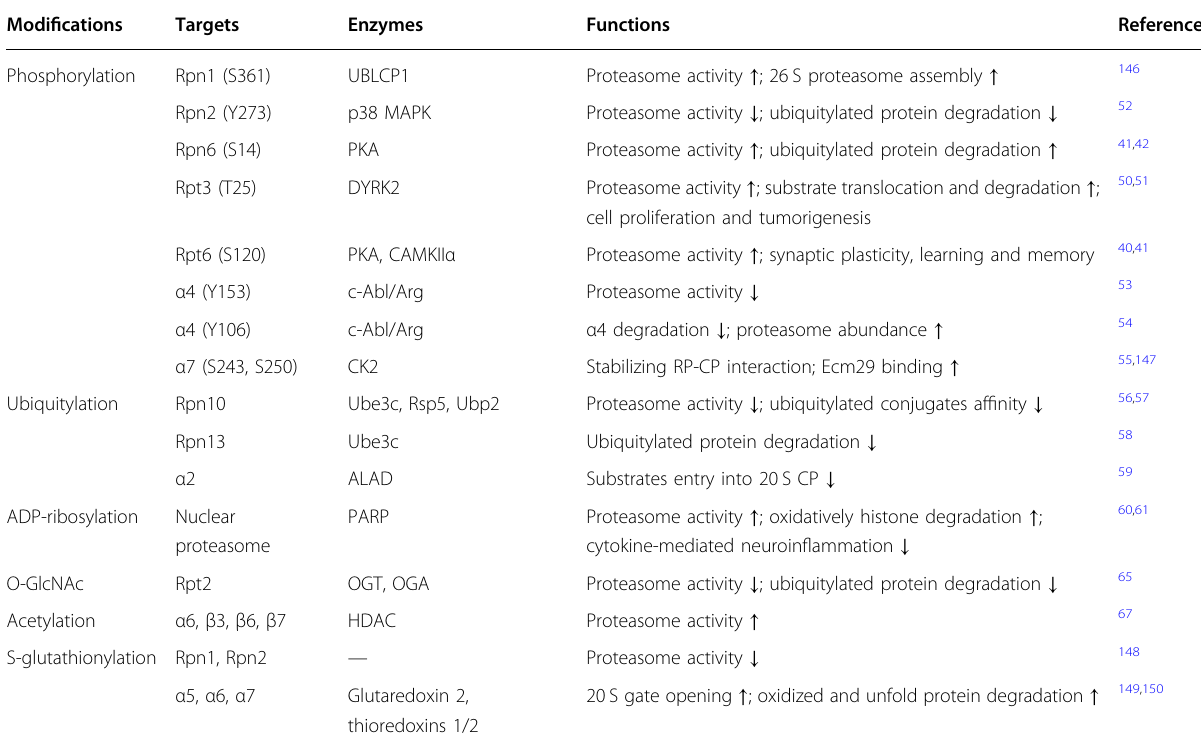
Table 2 An overview of proteasome related post-translational modi fi